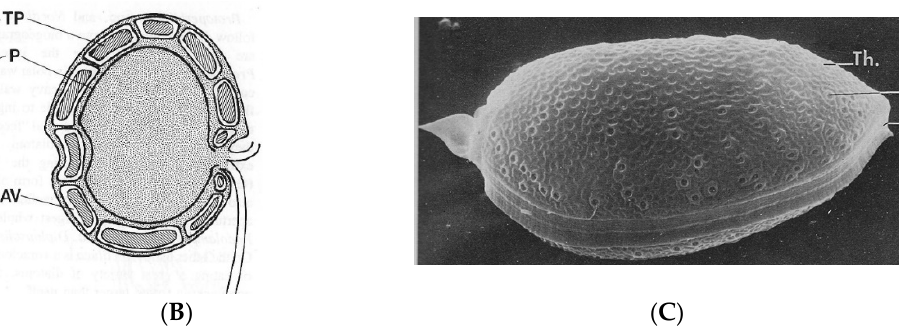
Figure 14. ( A ). Diagrammatic representation of longitudinal section through two dinoflagellates showing the relationship between the pellicle (P) and the amphiesmal vesicles (AV). ( A ). Heterocapsa type whose pellicle is formed by the fusion of the precursor material of each vesicle; ( B ). the Kofoidinium type whose pellicle is internal to the vesicles, separate from the thecal plates (TP). Reprinted/adapted with permission from [1]. ( C ). Scanning Electron Microscopic (SEM) view of Prorocentrum micans theca, Th. The view is dominated by the right valve, which is separated from the left valve (part of which is visible at the base of the image) by a longitudinal (sagittal) suture S. Numerous pores P are distributed through the theca. X= 3500. Reprinted/adapted with permission from Ref. [48].